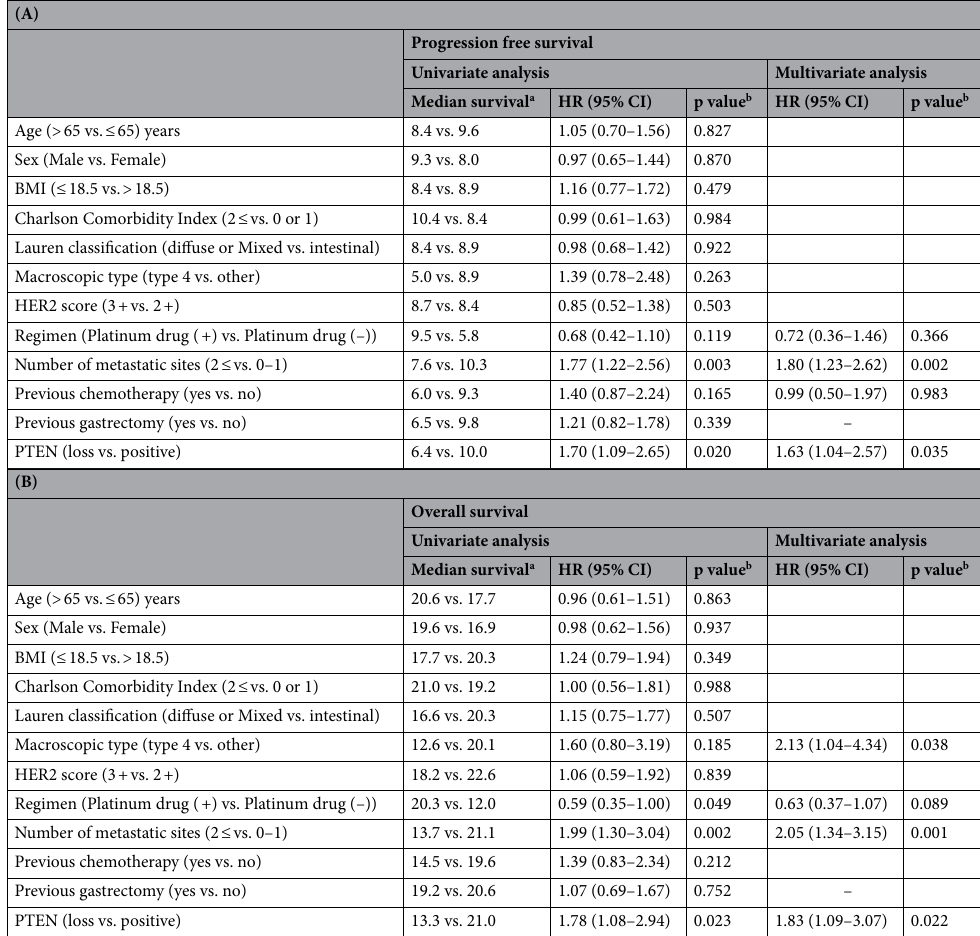
Table 4. Univariate and multivariate analyses of overall survival progression free survival. HR hazard ratio, 95% CI confidence interval; platinum drug, capecitabine or cisplatin; PTEN phosphatase and tensin homolog, HER2 human epidermal growth factor type 2. a Months. b Cox proportional hazard